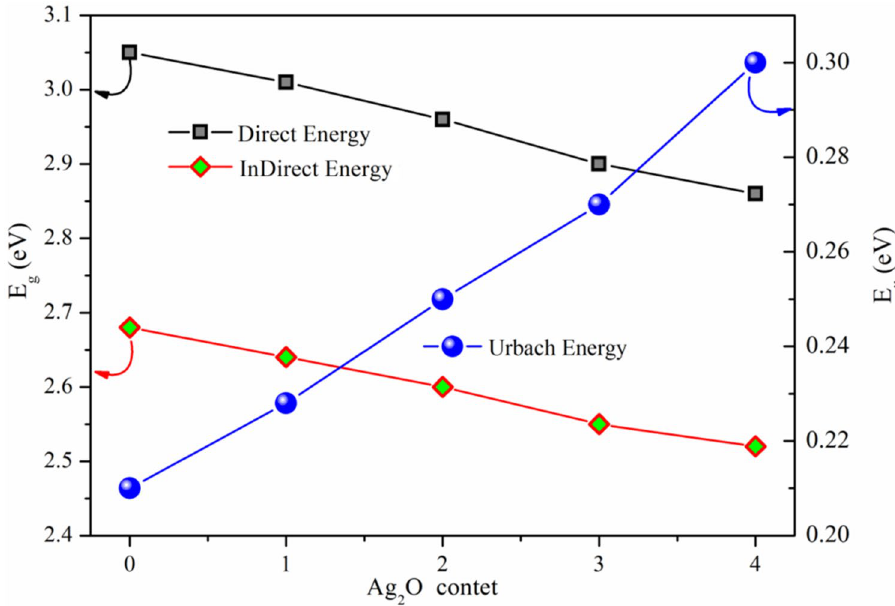
Figure 6. Dependence of energy gap and Urbach energy on Ag 2 O content for prepared glass samples.